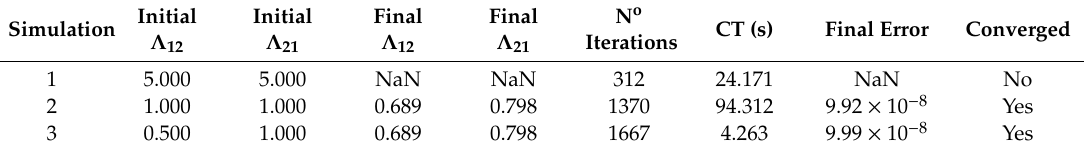
Figure 8. Proposed algorithm for the solution of the problem based on Levenberg–Marquardt method. Table 6. Results for simulation by using Levenberg–Marquardt